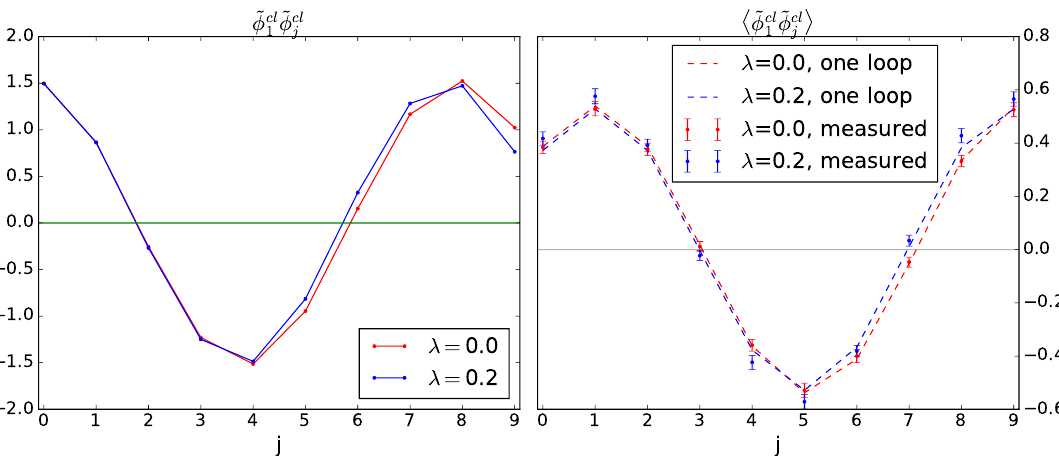
Figure 3 . Correlators for a single classical realisation (left) and averaged over initial conditions